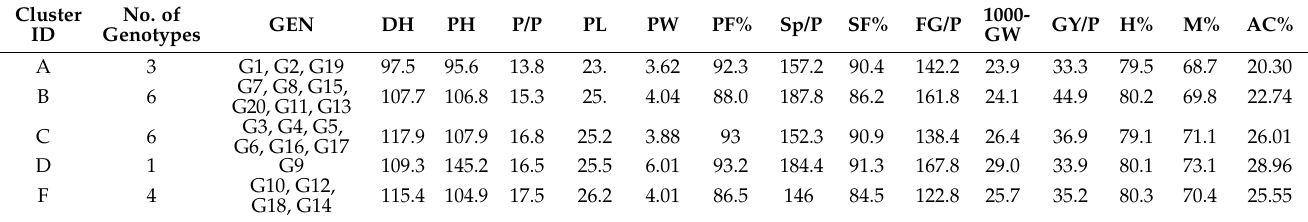
Table 10. Summary of cluster analysis of the twenty genotypes of rice.